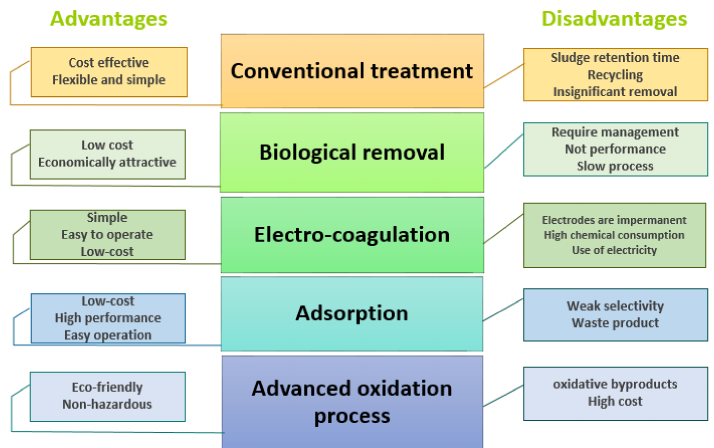
Figure 2. Advantages and disadvantages of different treatment process for the removals of